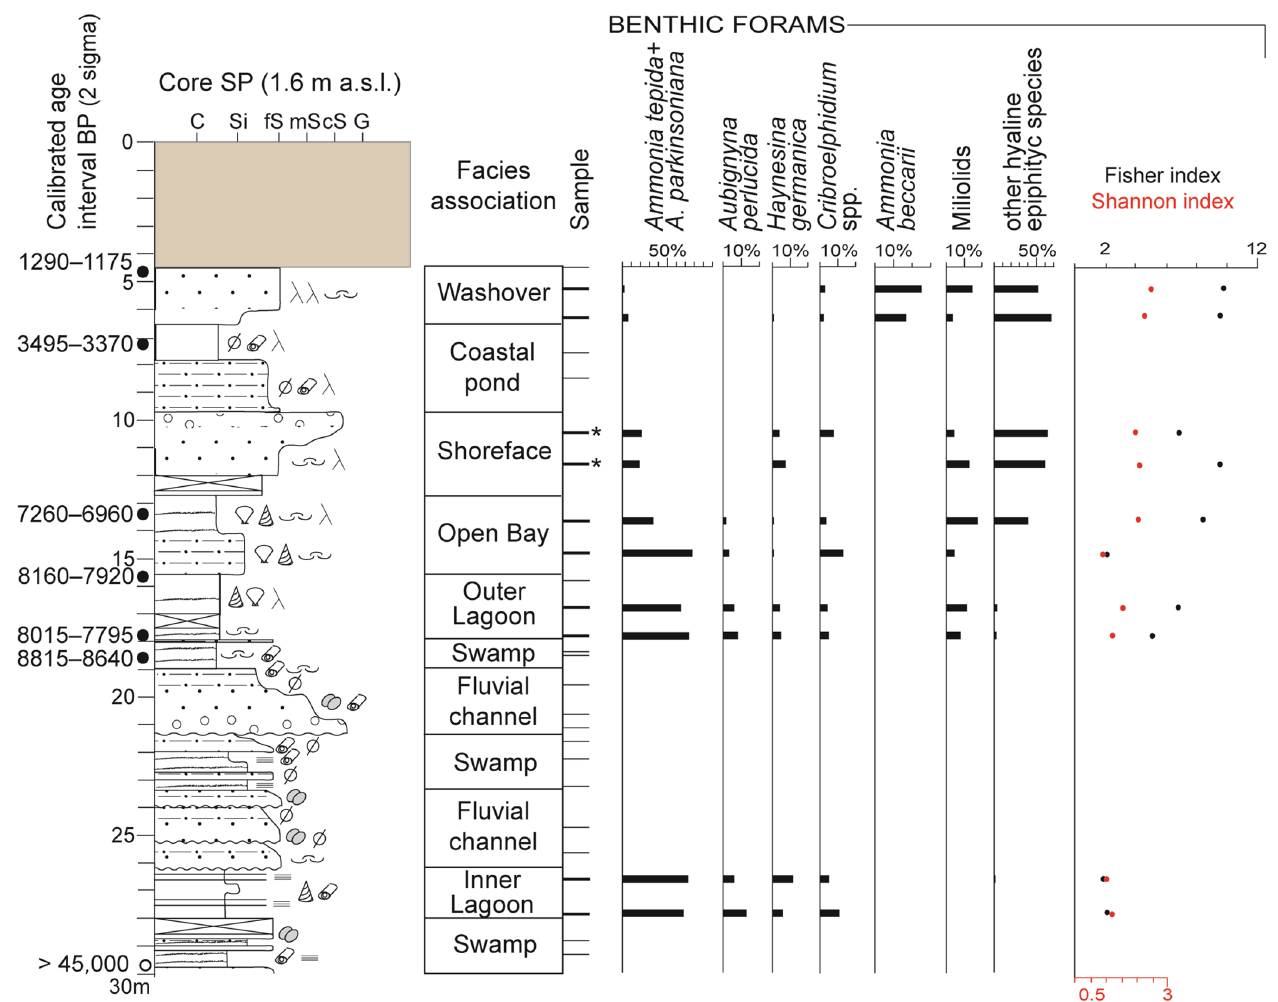
Figure 4. Stratigraphy, facies characterization, and vertical distribution of main benthic foraminiferal taxa and diversity indices of core SP. Samples with autochthonous foraminiferal fauna are reported as bold lines. Two samples containing less than 300 specimens are highlighted by an asterisk (*). C: Clay; Si: Silt; fS: Fine sand; mS: Medium sand; cS: Coarse sand; G: Gravel. The uppermost 4 m are composed of anthropogenic materials probably due to harbour construction. See legend in Figure 3 for lithological information.